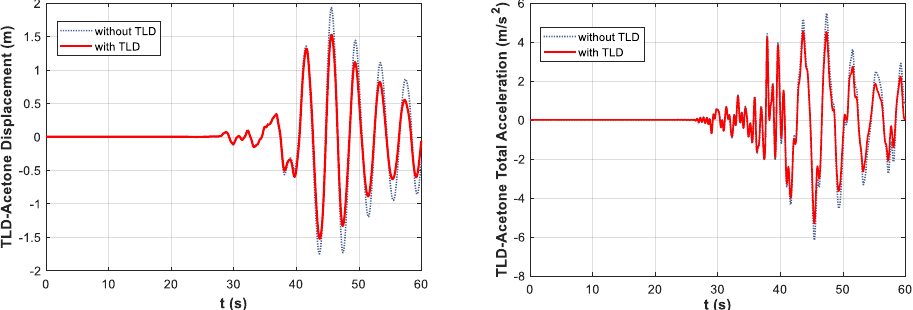
Figure 19. AHS optimization of the 40-story structure displacement – time and total acceleration – time graphs in the CHICHI/CHY101-N earthquake record for TLD – propanol.